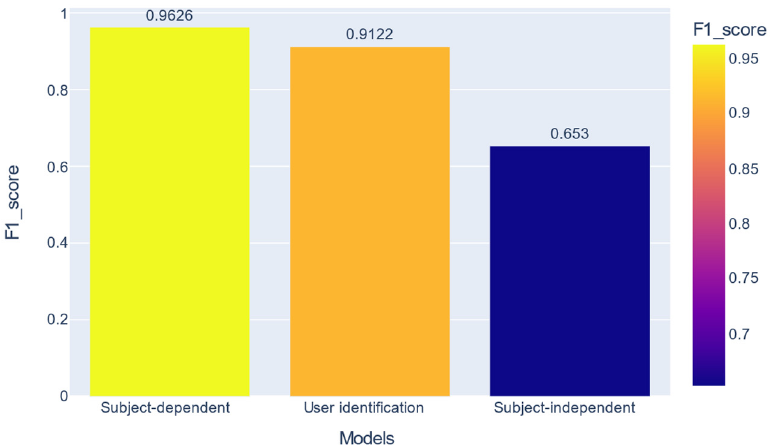
Figure 10. Comparison between the best performances obtained with HAR with SD, biometric user identification, and HAR with SI.